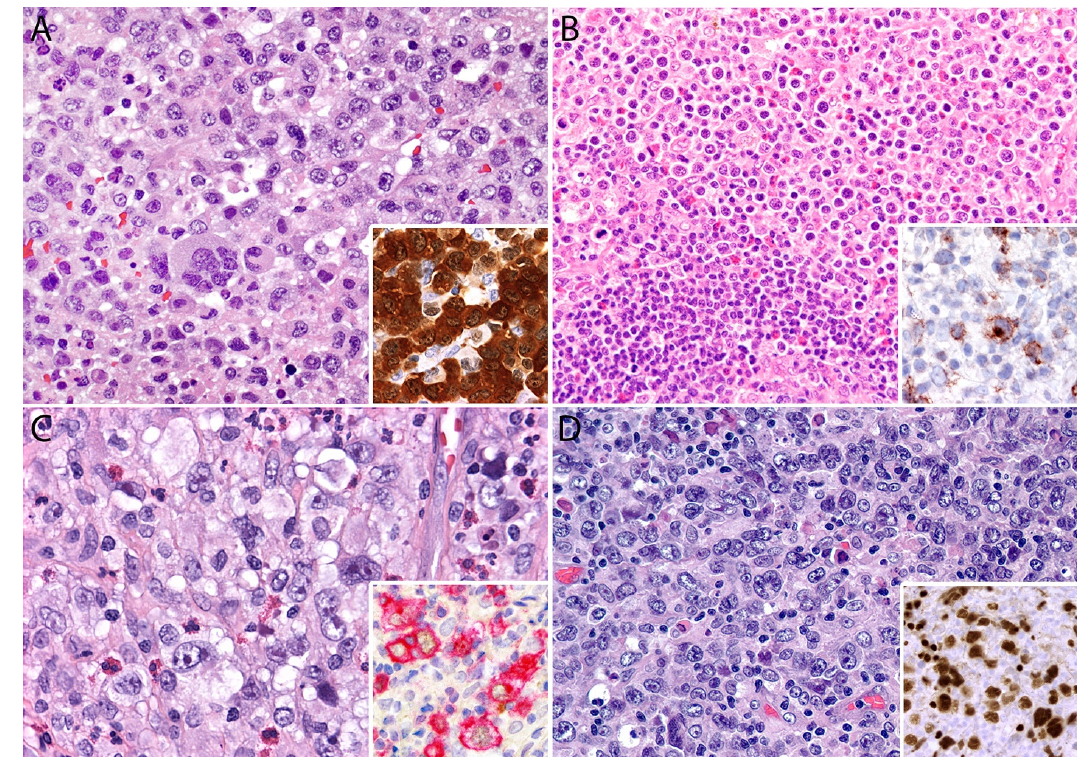
Figure 6. Differential diagnosis of systemic ALK- ALCL. ( A ) The morphology of ALK+ ALCL is indistinguishable from that of ALK- ALCL; however, the ALK immunostain is positive (inset). ( B ) Peripheral T-cell lymphoma, not otherwise specified, with large cells. The tumor cells have a paracortical distribution but are monotonous and not as pleomorphic as seen in ALCL. In addition, CD30 is only focally positive (inset). ( C ) Classic Hodgkin lymphoma. Reed-Sternberg cells are positive for CD30 (red) and dim PAX5 (inset, CD30/PAX5 double immunolabeling). ( D ) Anaplastic large B-cell lymphoma. The tumor cells are strongly positive for PAX5 (inset).